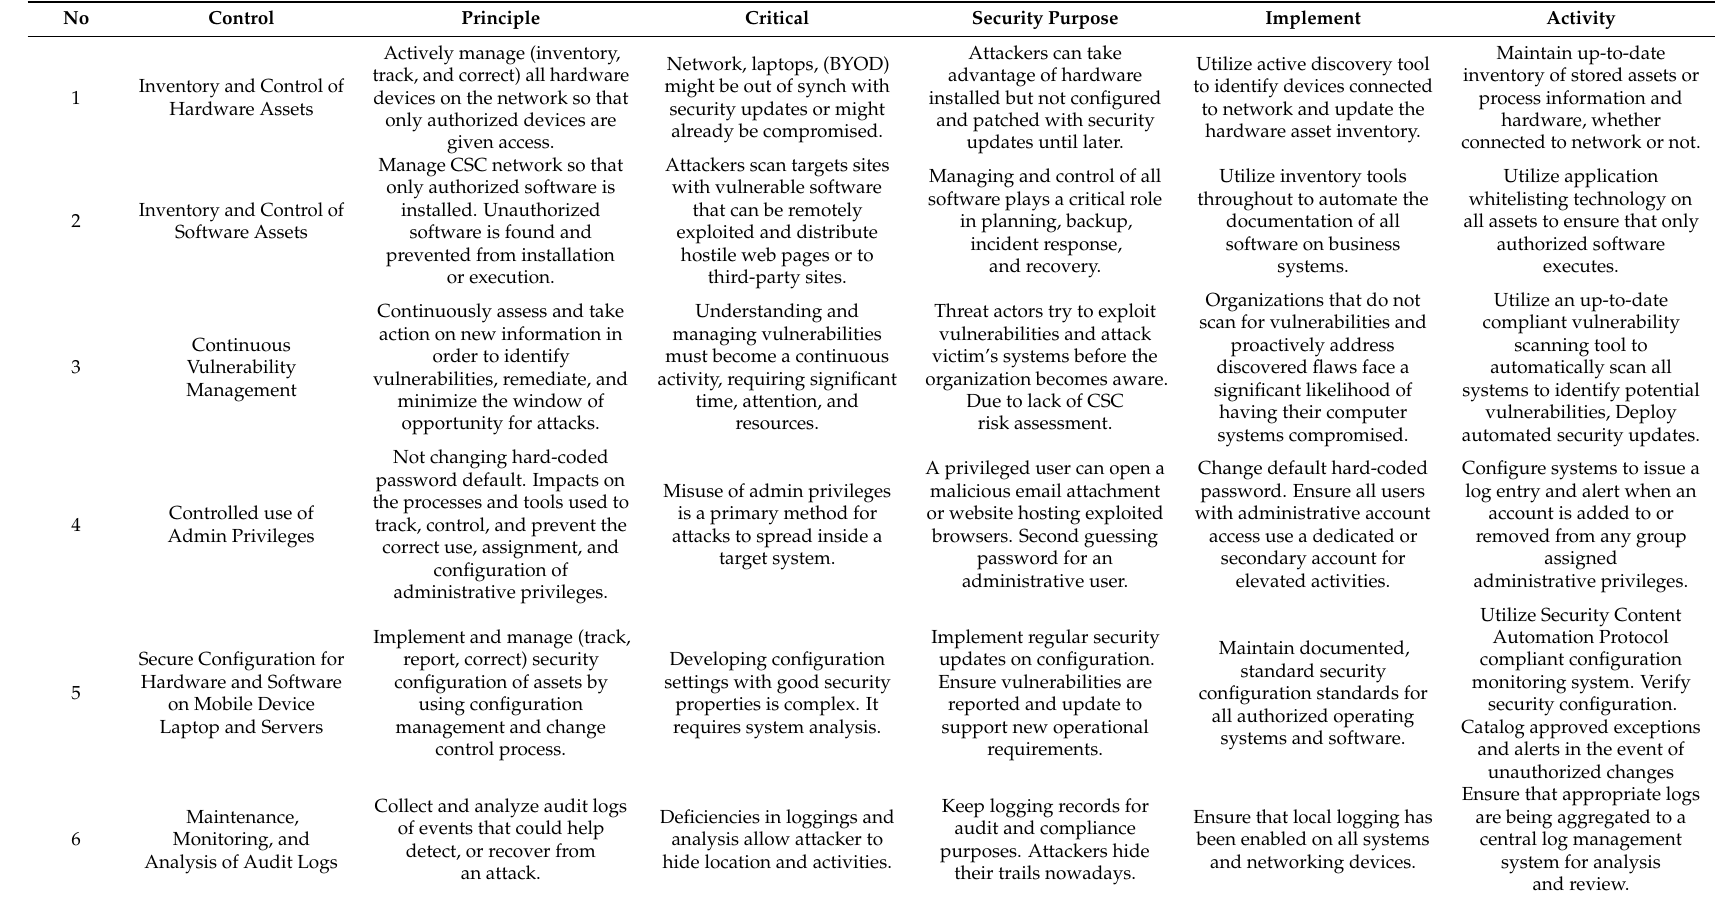
Table 5. Cyber Supply Chain